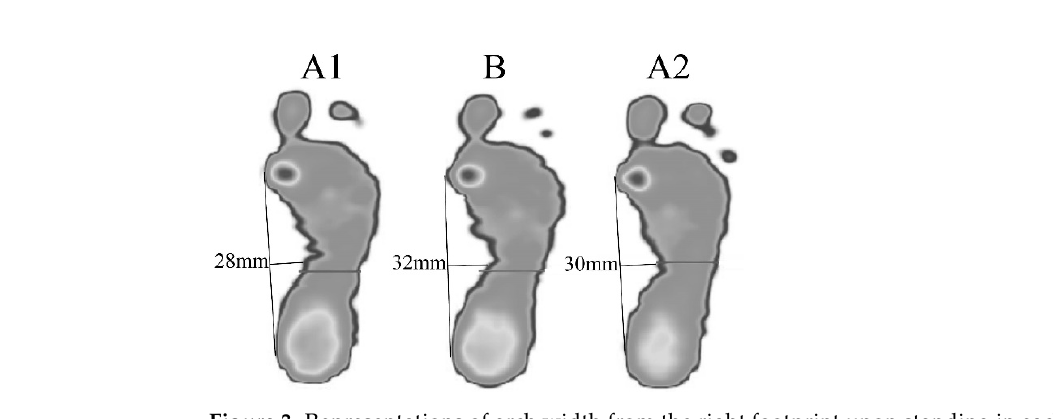
Figure 3. Representations of arch width from the right footprint upon standing in each period. The results of the kinematic parameters in gait for A1, B, and A2 are shown in Table 1. The maximum force and impulse of the hallux zone during gait increased from A1 to B and A2 (Figure 4). The impulse of the first metatarsal zone decreased from A1 to A2 (Figure 4). The amplitudes of the thoracic and pelvic displacement in the vertical and progressional directions were extended, as were those of thoracic displacement in the lateral direction from A1 to B and A2 (Figure 5). In the frontal plane, the trajectory of these displacements changed into a figure-of-eight (middle row of Figure 5), and the STV decreased from A1 to B and A2 (Table 1). The tactile pressure threshold of the hallux was 8 g in A1 and was lowered to 0.4 g by the third exercise session (Figure 6). There was no significant change in the first metatarsal head, and the threshold was in the range of 60–100 g (Figure 7).